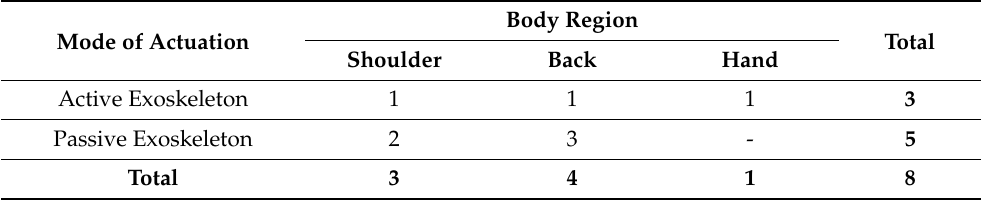
Table 2. Number of considered exemplary exoskeletons in the test